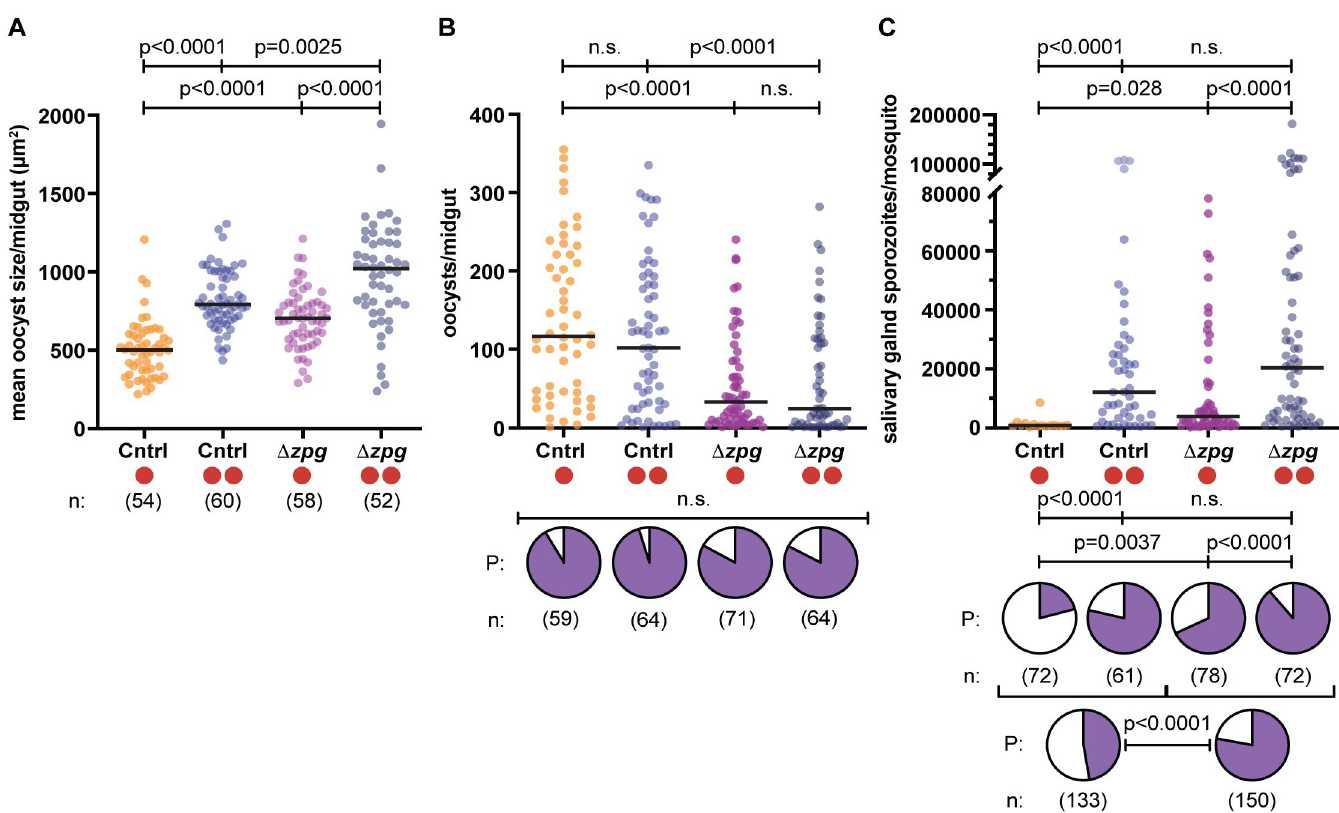
Fig 5. Parasite developmental rates are further enhanced in eggless mosquitoes. (A) Oocysts are significantly larger in Δ zpg (eggless) mutant females at 7 d pIBM after both one or two blood meals (Linear mixed model; #BF: p = 0.0001; genotype: p < 0.0001; FDR-corrected post-hoc Student’s t tests shown for all models) compared to controls (Cntrl). (B) Oocyst intensities are lower in Δ zpg mutant females compared to controls (Linear mixed model; #BF: p = 0.041; genotype: p < 0.0001), whereas oocyst prevalence (P, pie charts; χ 2 test: χ 2 = 6.5, d.f. = 3, n.s.) is unaffected. (C) Salivary glands sporozoite numbers are increased in both control and Δ zpg mutant females at 10 d pIBM after a second blood meal (Linear mixed model; #BF: p < 0.0001; genotype: p = 0.0056), with sporozoite prevalence (P, upper pie charts) also increased in the Δ zpg mutant background ( χ 2 test, χ 2 = 81, d.f. = 3, p < 0.0001), significantly at the first blood meal. Pooling data shows higher sporozoite prevalence in Δ zpg mutant population (P, lower pie charts) (Fisher’s exact test). Horizontal bars indicate median values. n = numbers of mosquitoes analyzed from 3 (A and B) or 4 (C) different experiments. n.s. = not statistically significant. See S1–S4 Tables for details of statistical